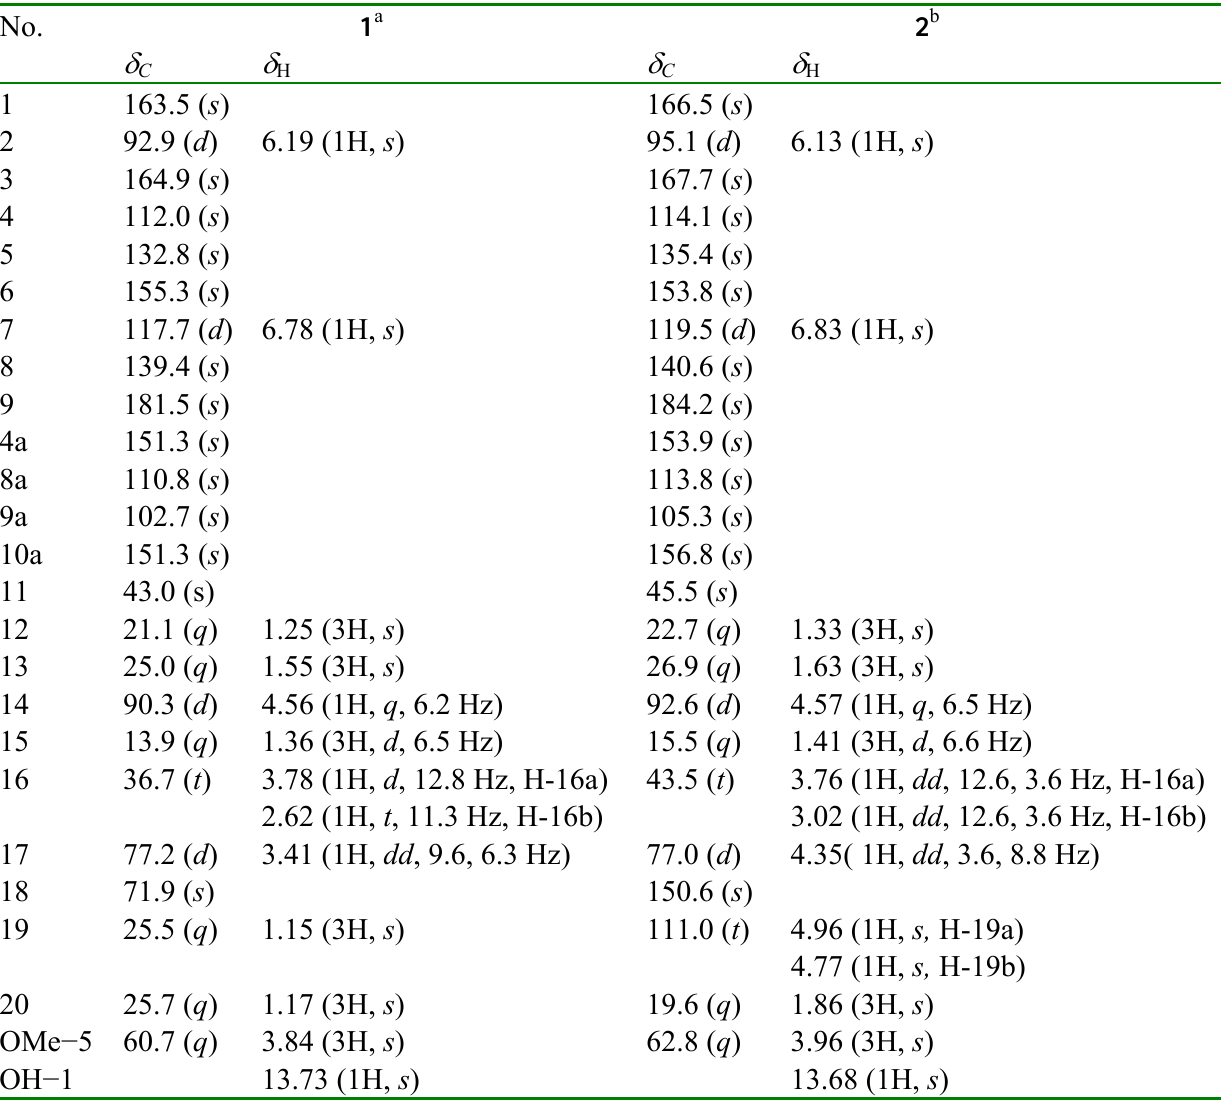
Table 1. 1 H- and 13 C-NMR data of 1 and 2 . ( 1 H at 400 and 13 C at 100 MHz; J in